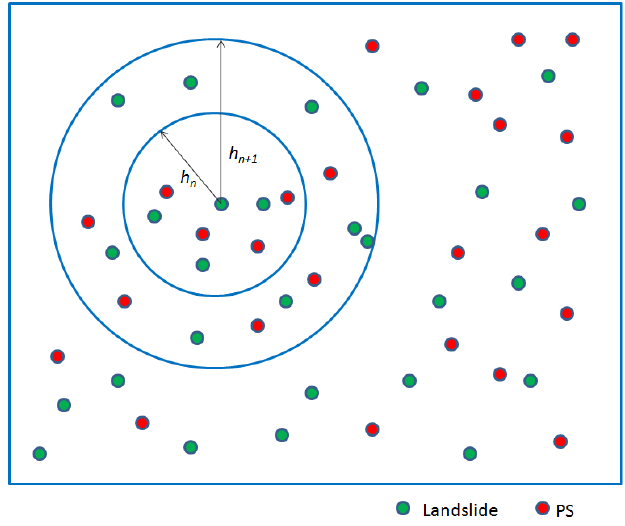
Figure 2. The bivariate K-function investigates spatial patterns of landslides and PSI point targets at multiple distances ( h ), counting the number of neighboring PS for each landslide within the given range of multiple